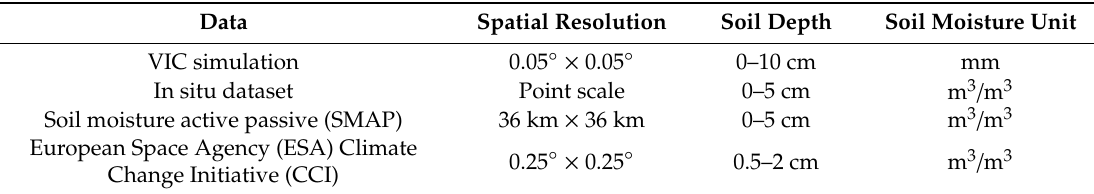
Table 2. Spatial resolutions, measure soil depths, and soil moisture units of the four soil moisture